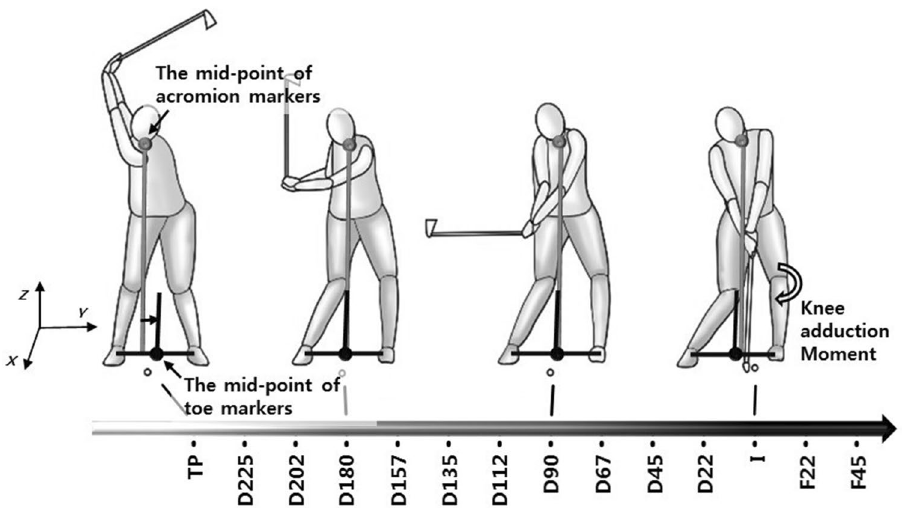
Figure 1. Fourteen sequential downswing events, peak knee adduction moment of the lead leg around impact, and shoulder position with respect to the mid-point of toe markers during the downswing. The horizontal axes show 14 sequential downswing events: transition of the pelvis (TP), downswing 225° (D225), downswing 202° (D202), downswing 180° (D180), downswing 157° (D157), downswing 135° (D135), downswing 112° (D112), downswing 90° (D90), downswing 67° (D67), downswing 45° (D45), downswing 22° (D22), impact (I), follow- through 22° (F22), and follow-through 45° (F45). X , Y , and Z front to back, side-to-side, and vertical axes, respectively. The direction of knee adduction moment of the lead leg (the tibia segment with respect to the thigh segment) and towards the target shoulder position (the mid-point of acromion markers with respect to the mid- point of toe markers) show positive